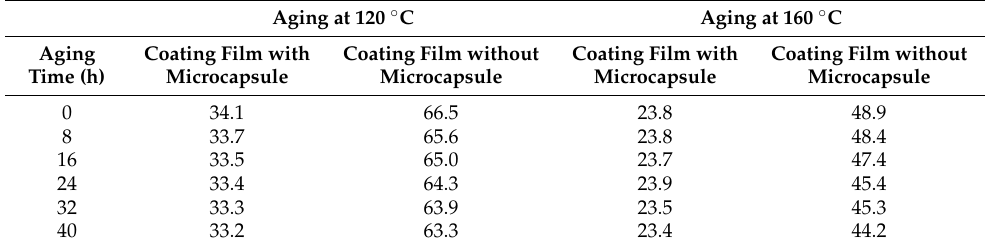
Table 8. Glossiness of coating film under high temperature aging environment.